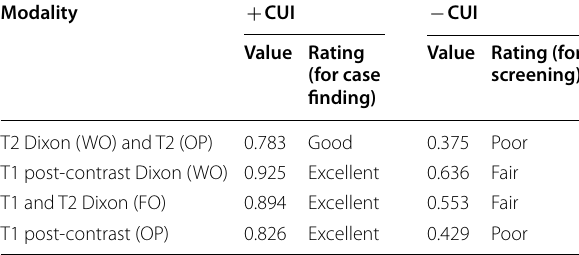
Measures were calculated by Clinical Utility Index Calculator (version 4), https:// www. psycho- oncol ogy. info/ cui. html, accessed December 2, 2021 [20] CUI positive clinical utility index (sensitivity multiplied by positive predictive value); CUI negative clinical utility index (specificity multiplied by negative − predictive value)